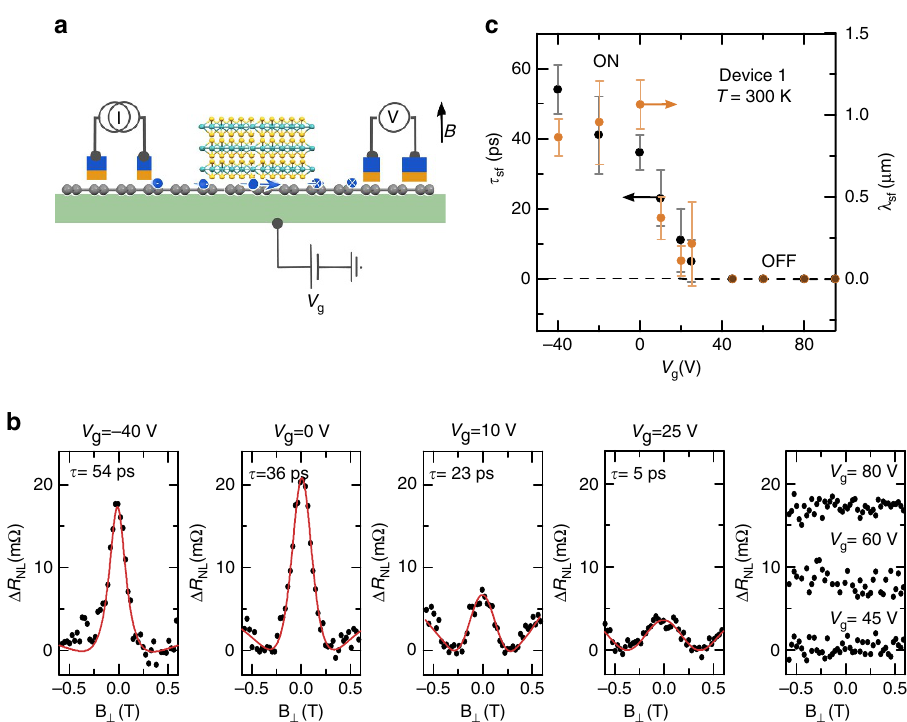
Figure 3 | Gate-controlled Hanle spin precession at room temperature. ( a ) NL Hanle geometry, where source and drain magnetization are aligned parallel while sweeping a perpendicular magnetic field B ? . ( b ) NL Hanle spin signal D R NL measured at 300K at different gate voltages. Measurements are performed at a constant current source of I ¼ 30 m A. The raw data points are fitted with equation (1) (red line) to extract spin lifetime t sf and diffusion length l sf. ( c ) The gate voltage V g dependence of spin lifetime t sf (black) and diffusion length l sf (orange) at 300K showing modulation of spin parameters from ON to OFF state. The error is derived from the error of the Hanle